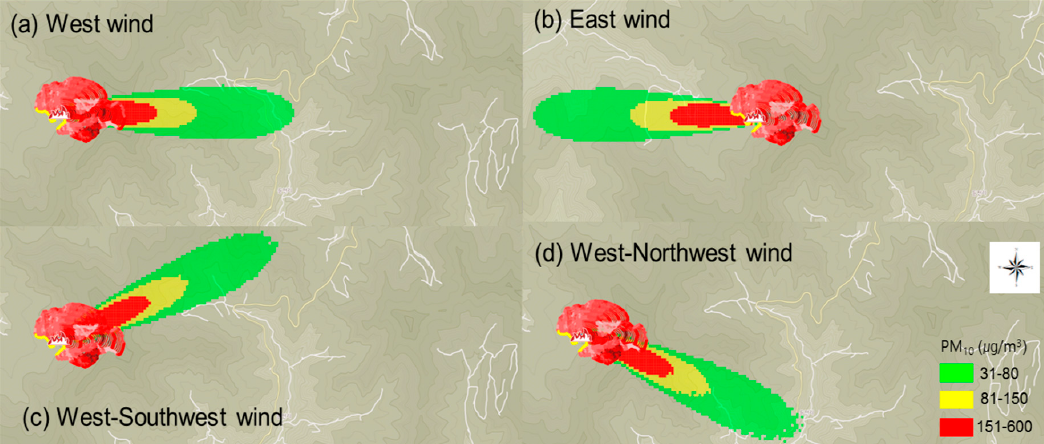
Comparison of the effects of wind directions on predicted dispersions of PM 10 plume concentration contours: ( a ) west winds, ( b ) east winds, ( c ) west-southwest winds, and ( d ) west-northwest winds. Both fires and predicted PM 10 surface concentrations are shown. PM 10 is coarse (<10 µm) particulate matter.